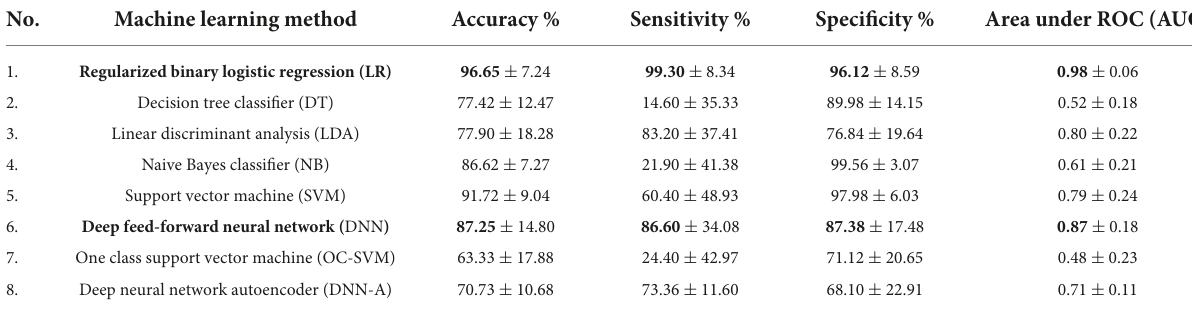
TABLE 3 Accuracy, sensitivity, specificity and AUC of the ML methods applied in post-operative STN-DBS motor outcome prediction using 20 selected